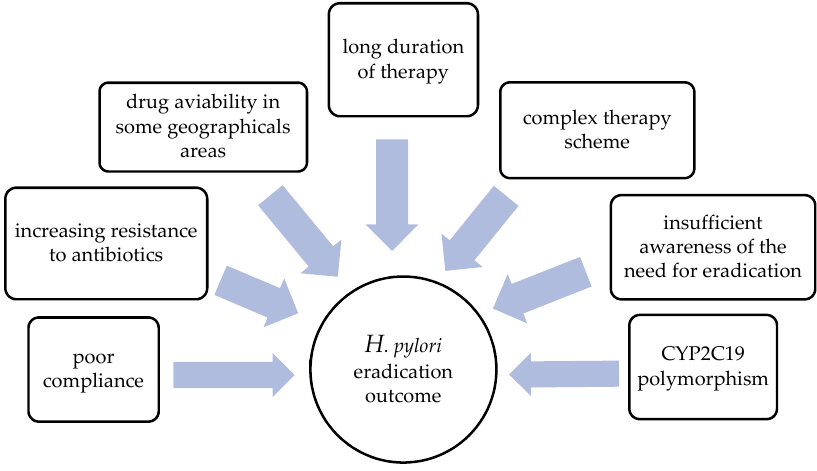
Figure 1. Factors affecting the efficiency of H. pylori eradication therapy.